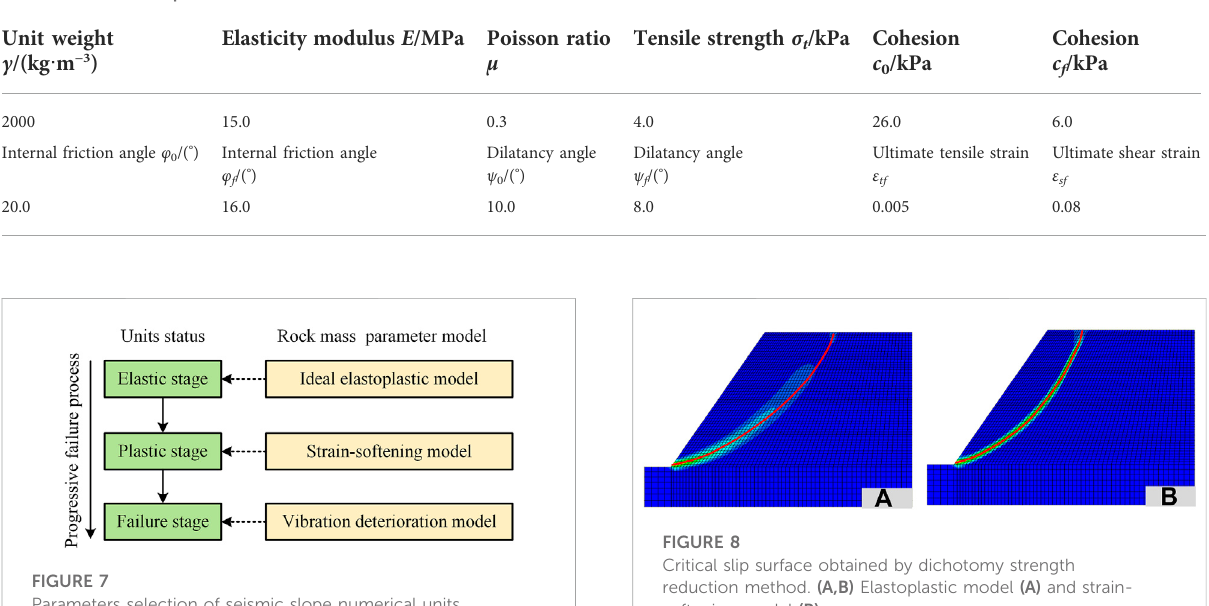
TABLE 1 Mechanical parameters of the rock mass.